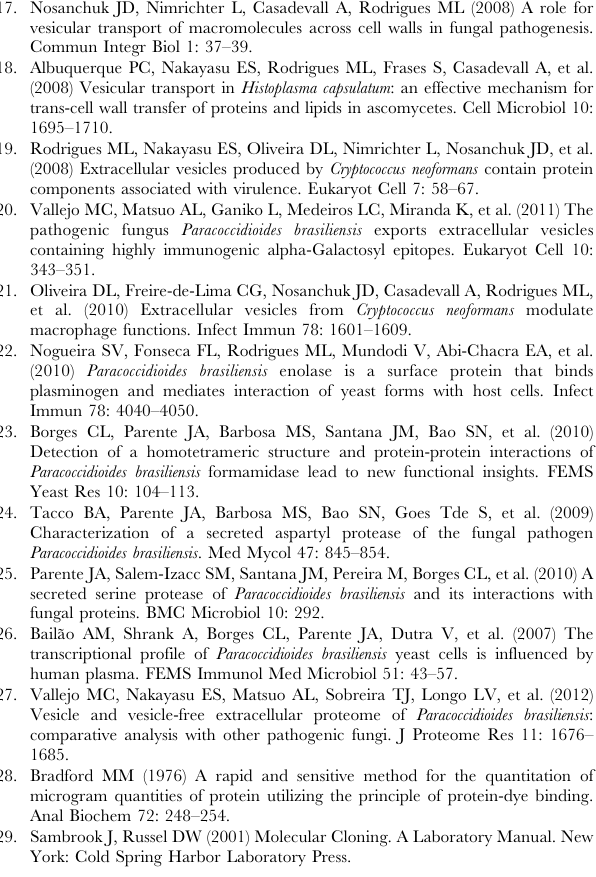
number of orthologues present in the Cryptococcus neoformans extracelular vesicles (Rodrigues et al, 2008). 6 Accession number of berg et al,